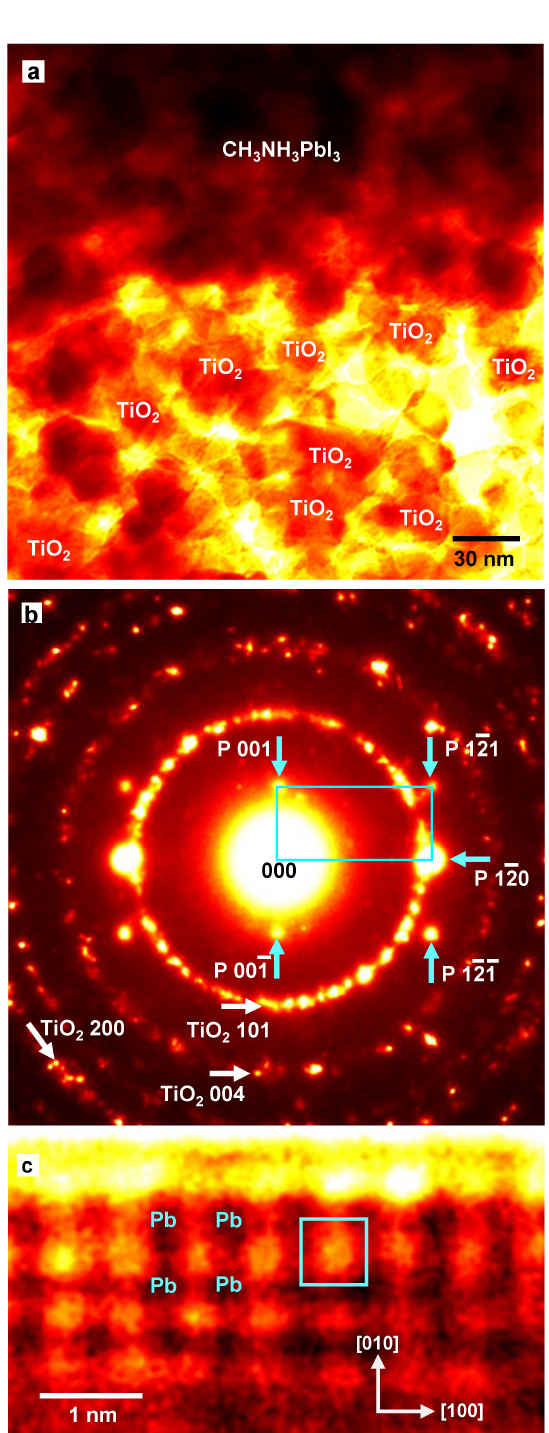
Figure 3: (a) TEM image and (b) electron diffraction pattern of TiO 2 /CH 3 NH 3 PbI 3 . “P” in the diffraction pattern indicates CH 3 NH 3 PbI 3 perovskite phase. Copyright (2014) The Japan Society of Applied Physics. (c) High-resolution TEM image of CH 3 NH 3 PbI 3